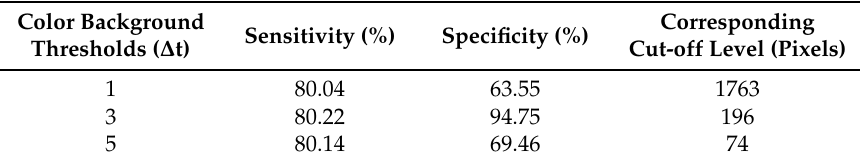
Table 2. Values of sensitivity and specificity that the developed detection sensor showed at the thresholds of color background (CB)